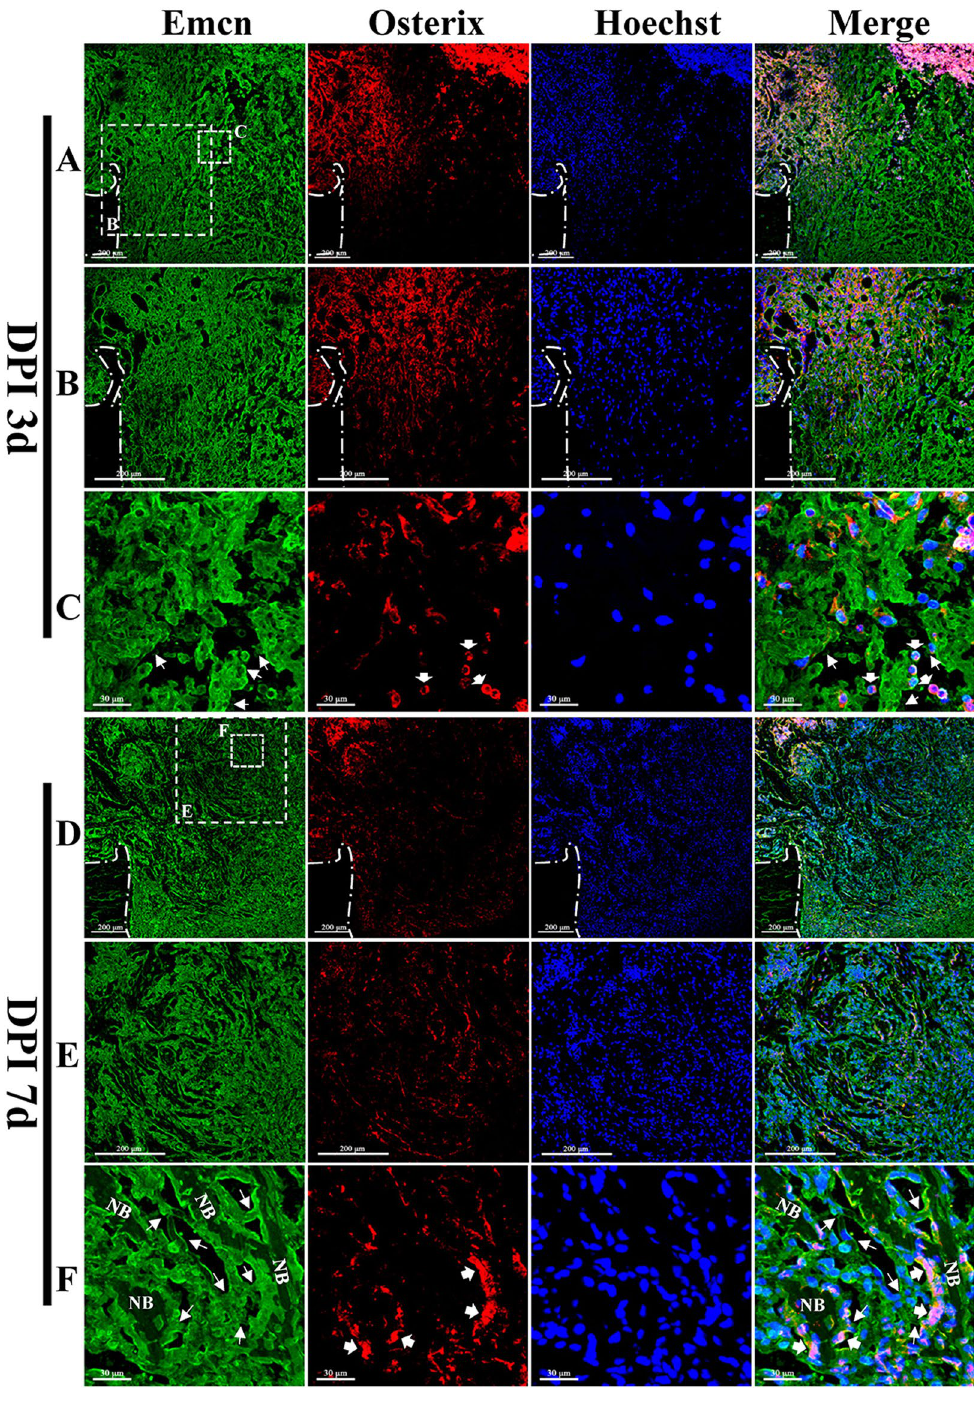
Figure 2. The invasion of Emcn + capillaries and the proliferation and migration of osterix + cells during the repair process. ( A – C ) The distribution of Emcn + vessels and osterix + cells at 3 days post-injury. ( A ) Emcn + vessels were extensively distributed in the injured area, exhibiting a denser distribution in the lateral area and looser distribution in the inner area. ( B ) Proliferating and migrating osterix + cells were primarily distributed at the lateral side of the repairing region, and displayed a migrating tendency to the inner. ( C ) The sprouting of Emcn + capillaries could be observed inside the repair area (white thin-tailed arrow). Some osterix + cells were tightly connected with Emcn + capillaries (white thick-tailed arrow). ( D – F ) The distribution of Emcn + capillaries and osterix + cells at 7 days post- injury. ( D ) Emcn + capillaries were distributed in a more orderly manner, and were observed both at the surface and the periphery of newly formed trabecular bones. Near the frontier growth area distributed a large number of osterix + cells. ( E ) Most osterix + cells were distributed on the surface of newly formed trabecular bones. ( F ) Branches of Emcn + vessels among the new trabecular bones could be observed (white thin-tailed arrow). Osterix + Emcn + cells were identified and were distributed at the surface of new trabecular bones (white thick-tailed